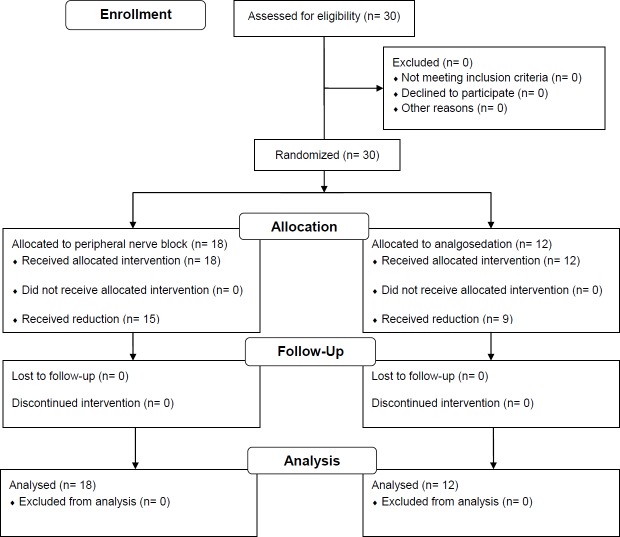
Flow diagram summarizing the study design.